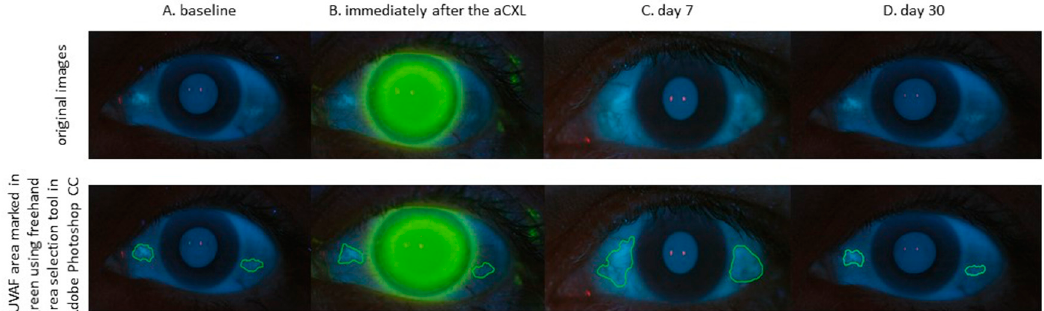
Figure 1. Panel of 8 conjunctival ultraviolet autofluorescence digital images of the left eye of a patient aged 28, diagnosed with keratoconus in the 3rd stage according to the Amsler classification. Photos taken during the study visits—baseline, immediately after the aCXL procedure, day 7, and day 30. Photos presented in the original and after processing in Adobe Photoshop CC with manual marking of the CUVAF area in green. Abbreviations: aCXL, accelerated corneal cross-linking; CUVAF, conjunctival ultraviolet autofluorescence.